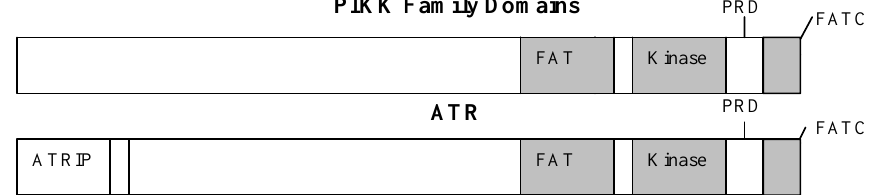
Figure 1. Structural domains of ATR in comparison to other PIKK family members. The shaded domains share the highest degree of sequence homology. ATRIP (ATR-interacting protein), FAT (FRAP, ATM, TRRAP), PRD (PIK regulatory domain), FATC (FAT domain at the carboxyl